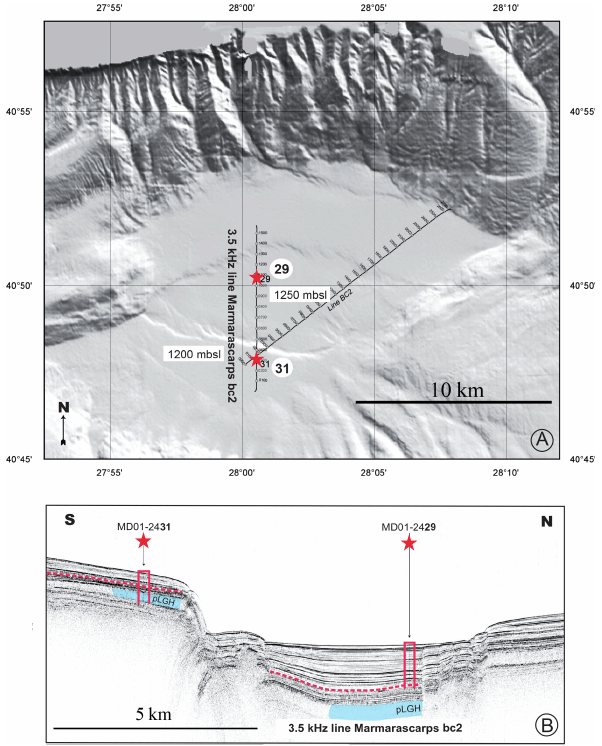
Figure 4. Detailed location of the Orta/Central Basin’s long cores. (a) Bathymetry taken from Rangin et al. (2001); (b) very-high- resolution seismic profile from the MARMARASCARPS survey (Armijo et al., 2005; Uçarku¸s, 2010). Red dashed line indicates the limit between nonmarine (below) and marine sequences (also un- derlined in Figs. 3, 4 and